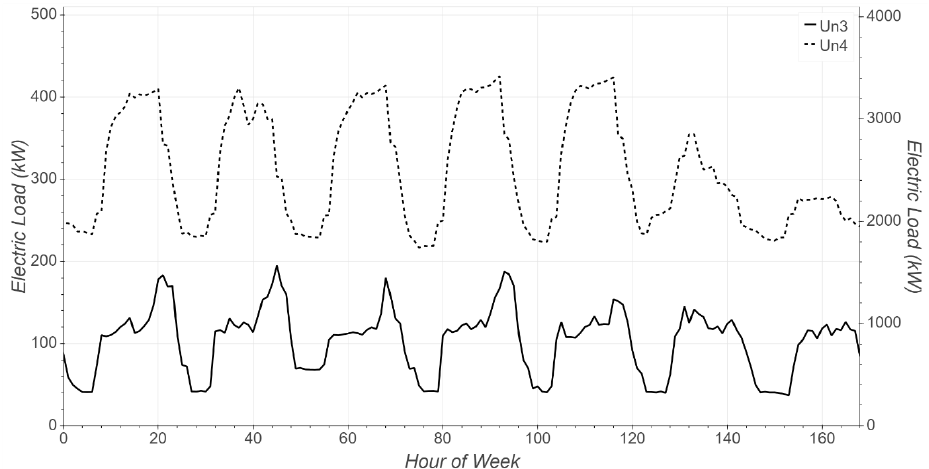
Figure 5. Example time-series electric load data for Un3 (solid line, left y -axis) and Un4 (dashed line, right y -axis). Hours 120–168 are weekend days.